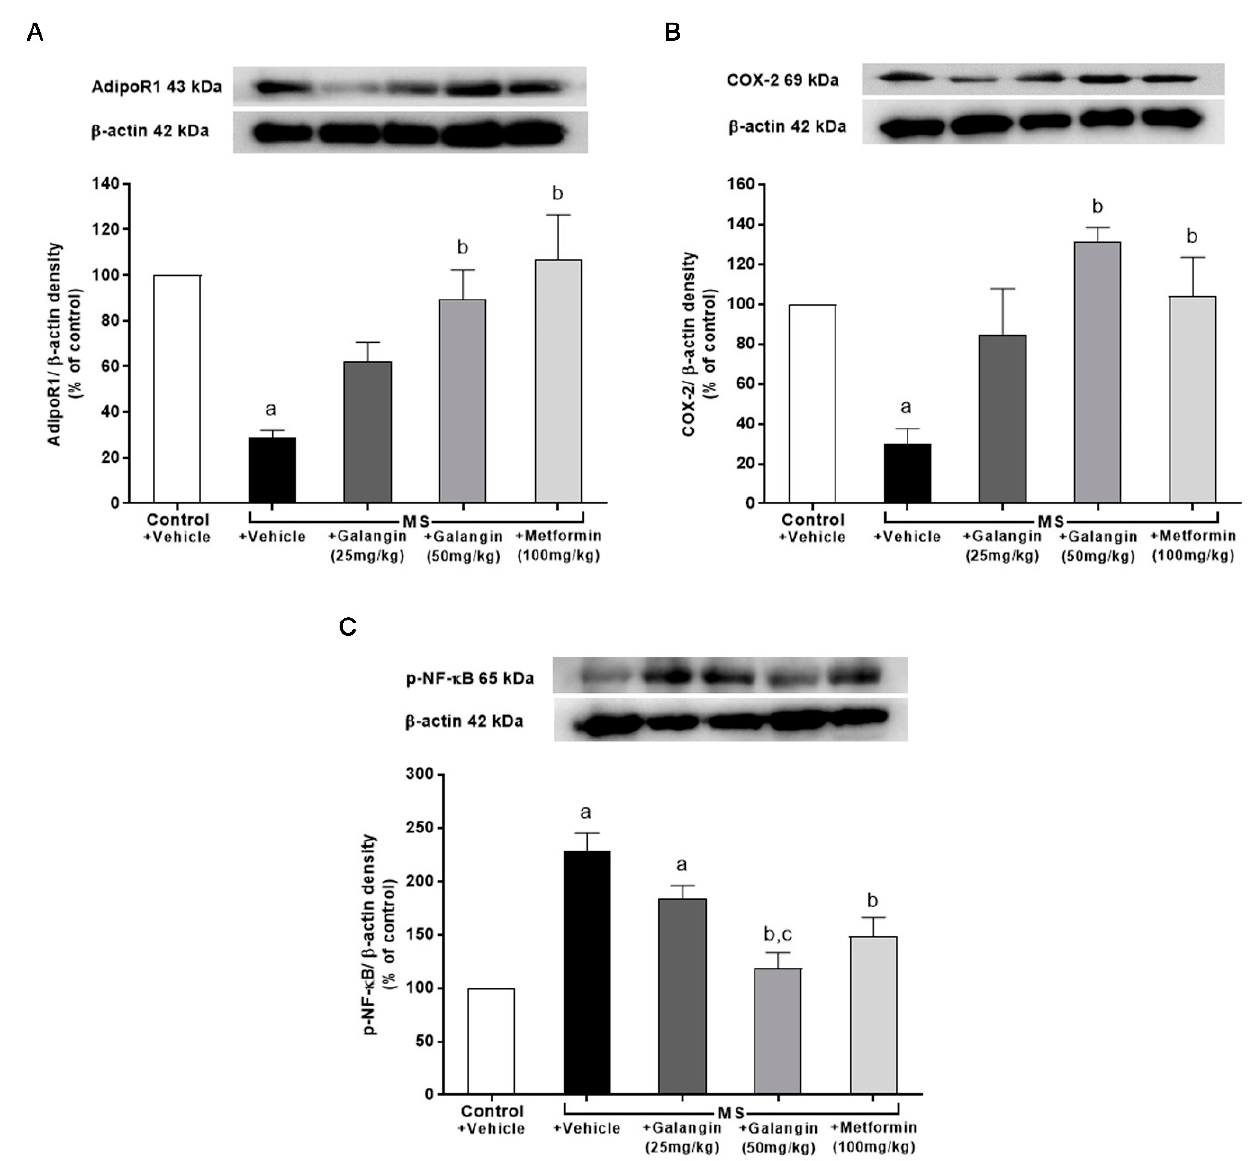
Figure 8. Effects of galangin and metformin treatments on protein expression in heart: ( A ) AdipoR1, ( B ) COX-2, and ( C ) p-NF- κ B. Data are presented as the mean ± S.E.M. ( n = 3–4). a p < 0.05 vs. the control group and b p < 0.05 vs. the MS group. c p < 0.05 vs. MS + Galangin (25 mL/kg) group. AdipoR1: adiponectin receptor 1; COX-2: cyclooxygenase-2; p-NF- κ B: phospho-nuclear factor kappa B.